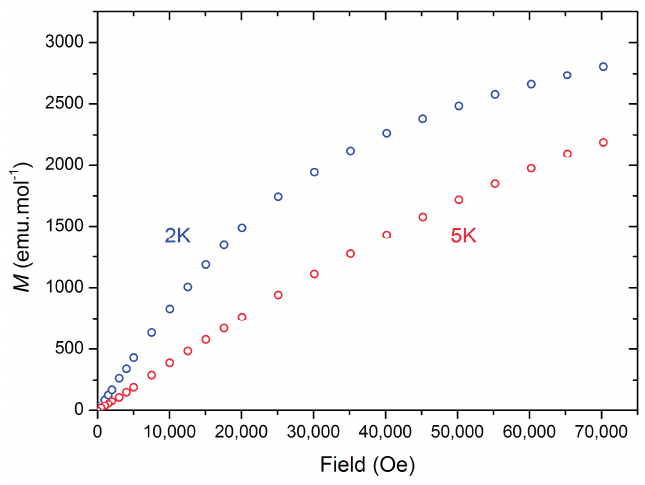
Figure 7. Magnetization ( M , μ B ) vs. Field (Oe) of 2 at 2 K and 5